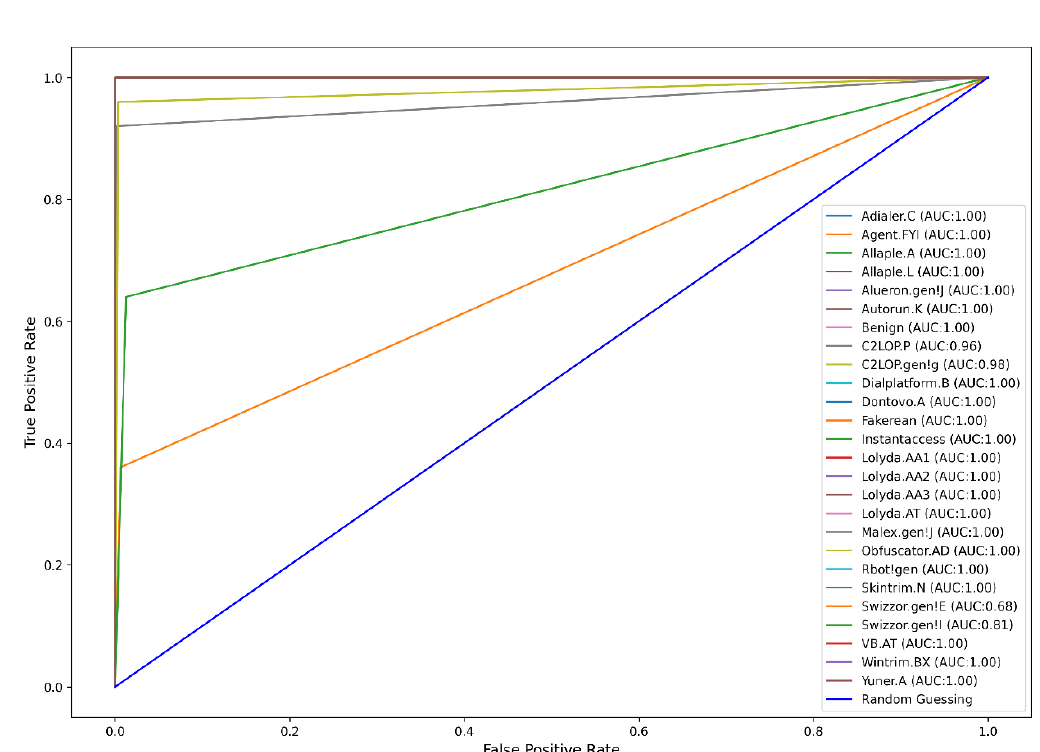
Figure 14. ROC curves with area under curve values for classification with class balancing and benign class.